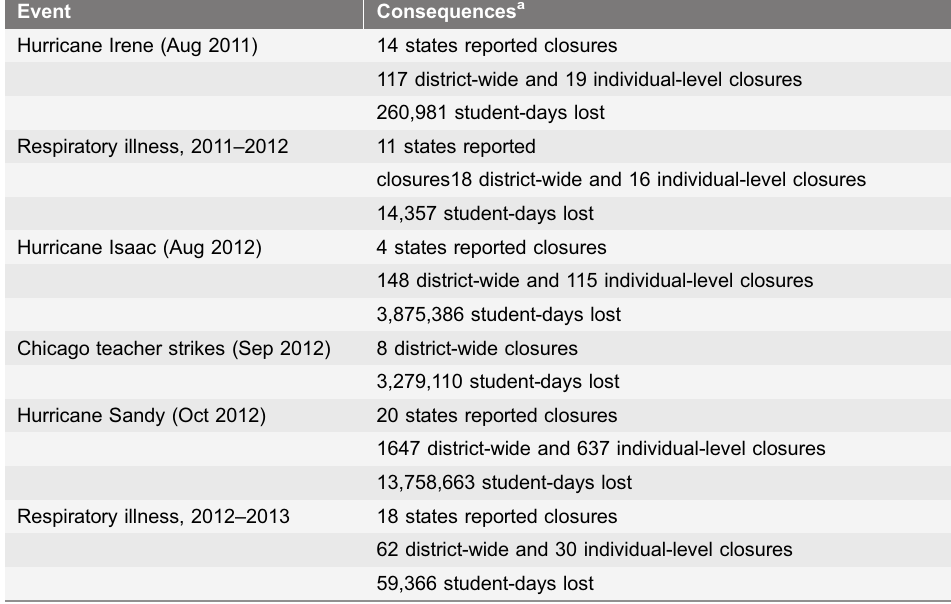
Table 4. Selected events causing school closures — United States,